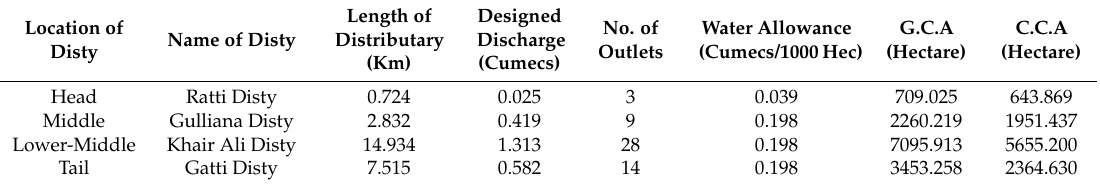
Table 2. Quantitative characteristics of selected distributary